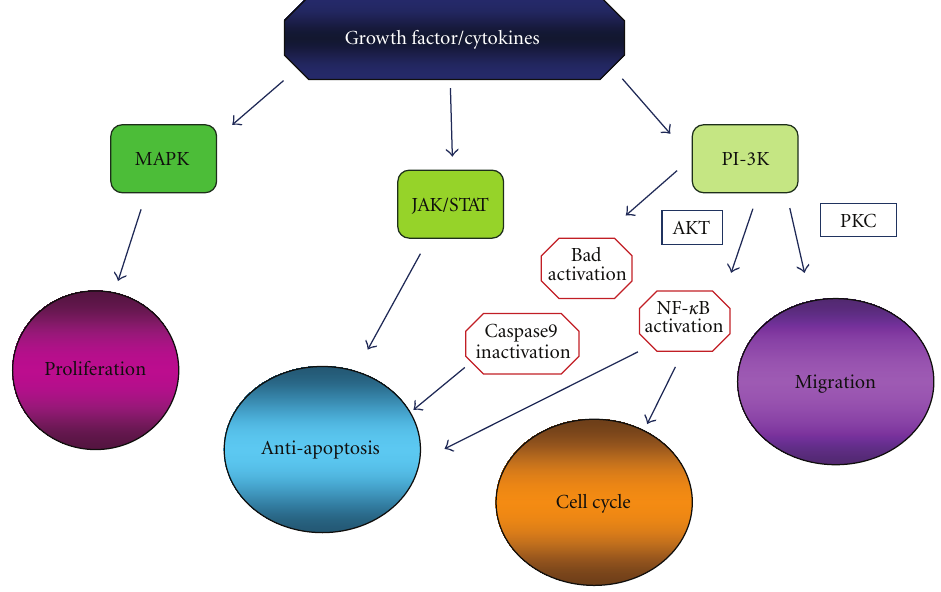
Figure 5: Signaling pathways activated by BM